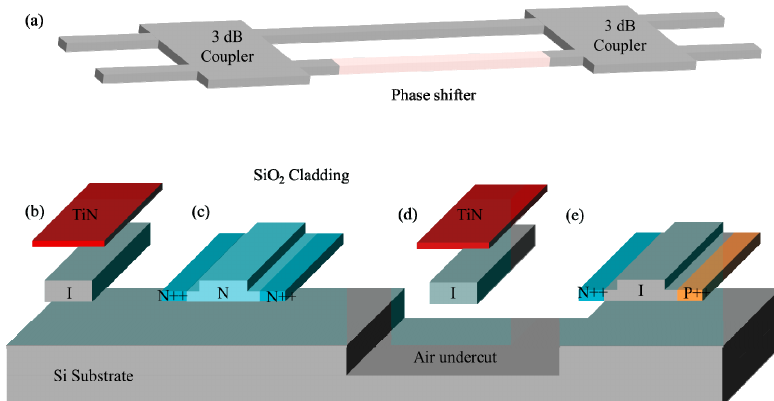
Figure 1. ( a ) Schematic of 2 × 2 Mach-Zehnder interferometer (MZI) switch cell. Cross-sections of waveguide phase shifters: ( b ) thermo-optic (T-O) phase shifter using a metal heater ( c ) T-O phase shifter using a doped resistive heater ( d ) suspended T-O phase shifter using a metal heater ( e ) electro-optic (E-O) phase shifter.